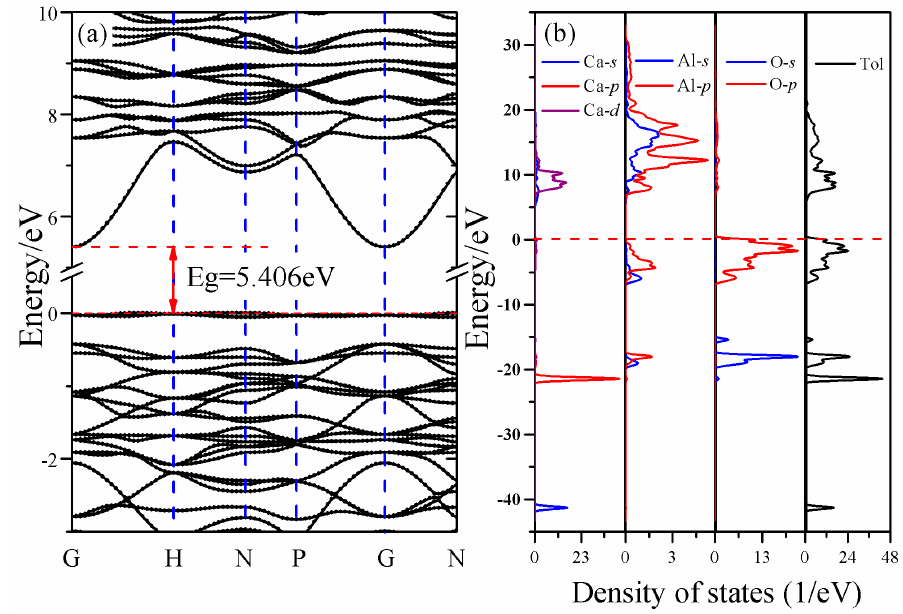
Figure 3. Electronic structures of CAO: ( a ) the electronic band structures and ( b ) the total and partial densities of states.